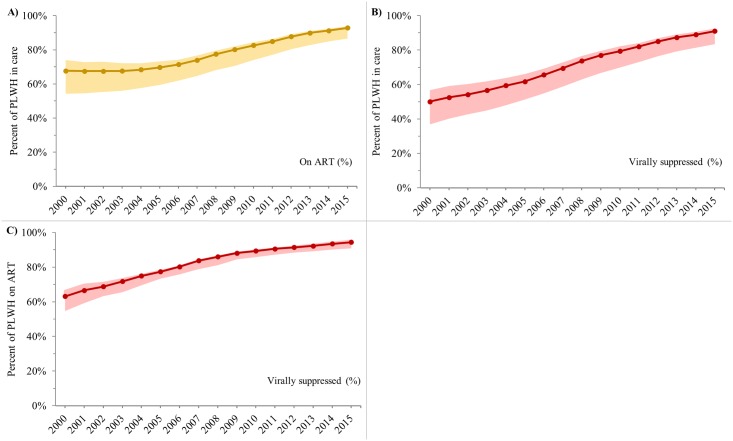
Trends in conditional cascade indicators, Ontario HIV Laboratory Cohort, 2000–2015.A) Percent of diagnosed PLWH in care who were on ART. B) Percent of diagnosed PLWH in care who were virally suppressed. C) Percent of diagnosed PLWH on ART who were virally suppressed. Solid lines represent “main” estimates and shaded areas represent “upper” and/or “lower” bounds. See Table 1 for indicator definitions. PLWH = people living with HIV. ART = antiretroviral treatment.